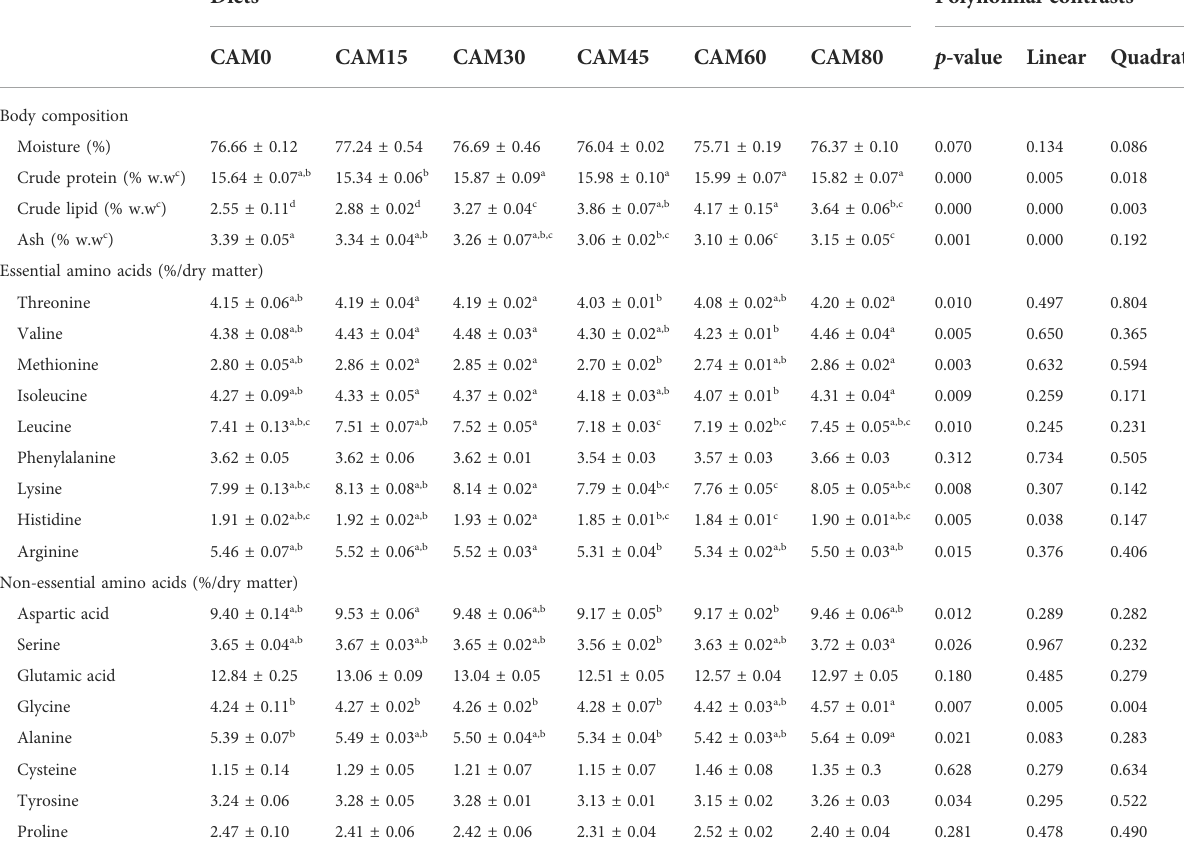
TABLE 7 Body composition and dorsal muscle amino acids pro fi le (Means ± S.E.M) a